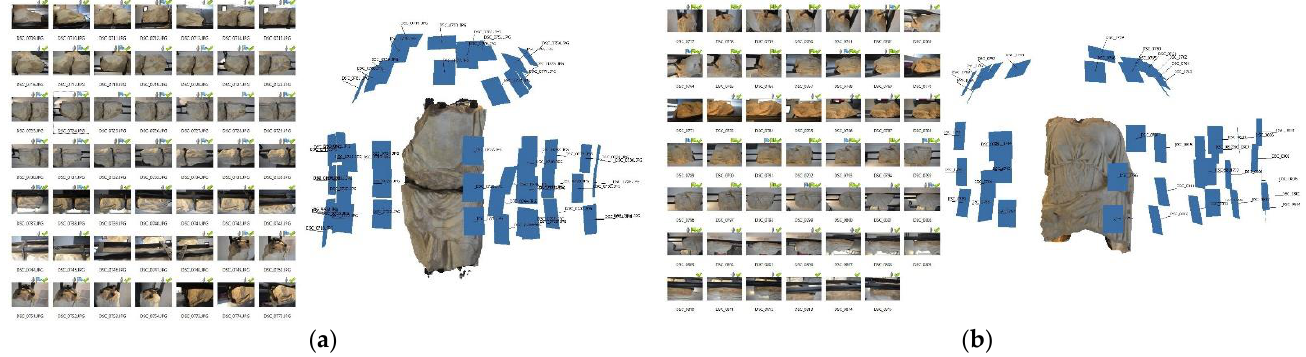
Figure 7. Agisoft-Metashape photo alignment step of the Aesculapius ( a ) and Hygeia statues ( b ).